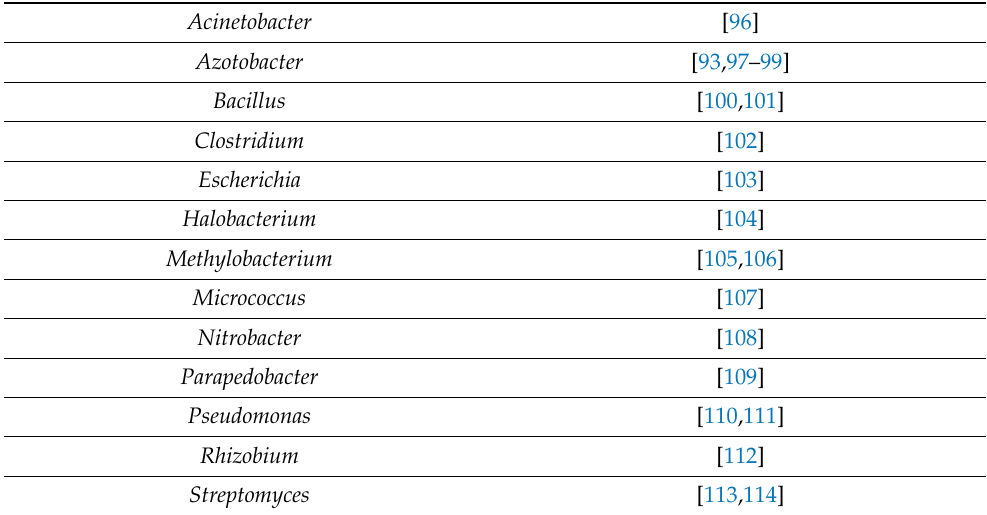
Table 1. Some representatives of prokaryotes that are capable of synthesizing PHA as an intracellular energy source.